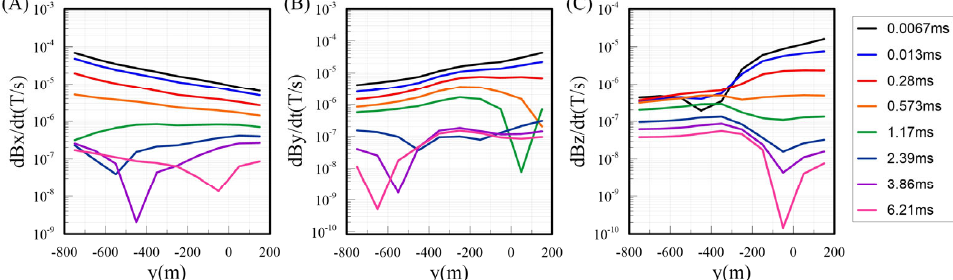
Figure 11. Multi ‐ component responses for the sulfide ore body model at x= 50 m. ( A ), ( B ) and ( C ) Figure 11. Multi-component responses for the sulfide ore body model at x = 50 m. ( A – C ) are the are the X component, Y component and Z component, respectively. X component, Y component and Z component,